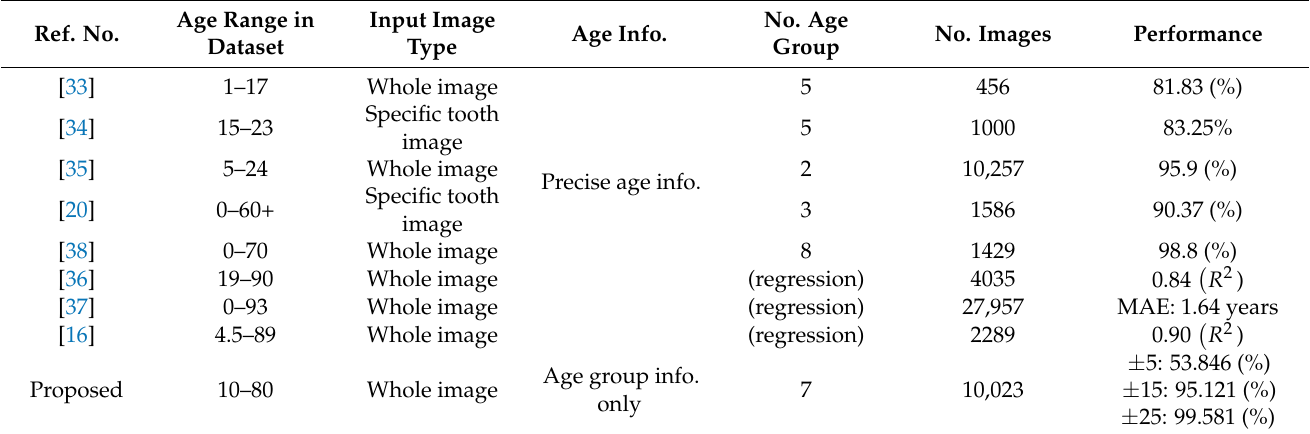
Table 3. Accuracy comparison to the recent results for tooth age estimation.